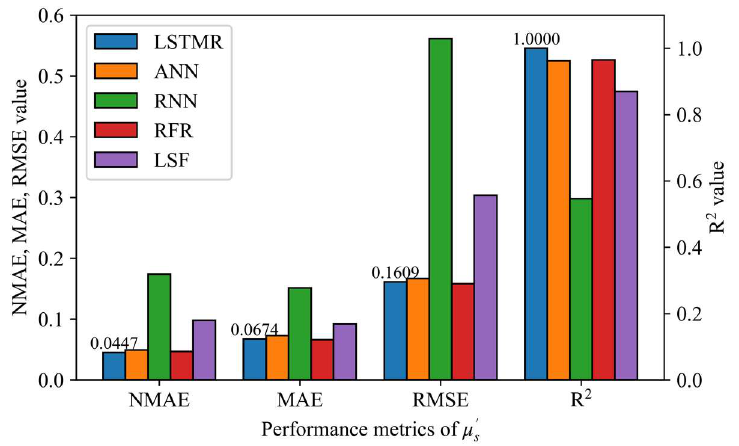
Figure 5. Performance metrics for different models in the phantom experiment for absorption coef- ficient.